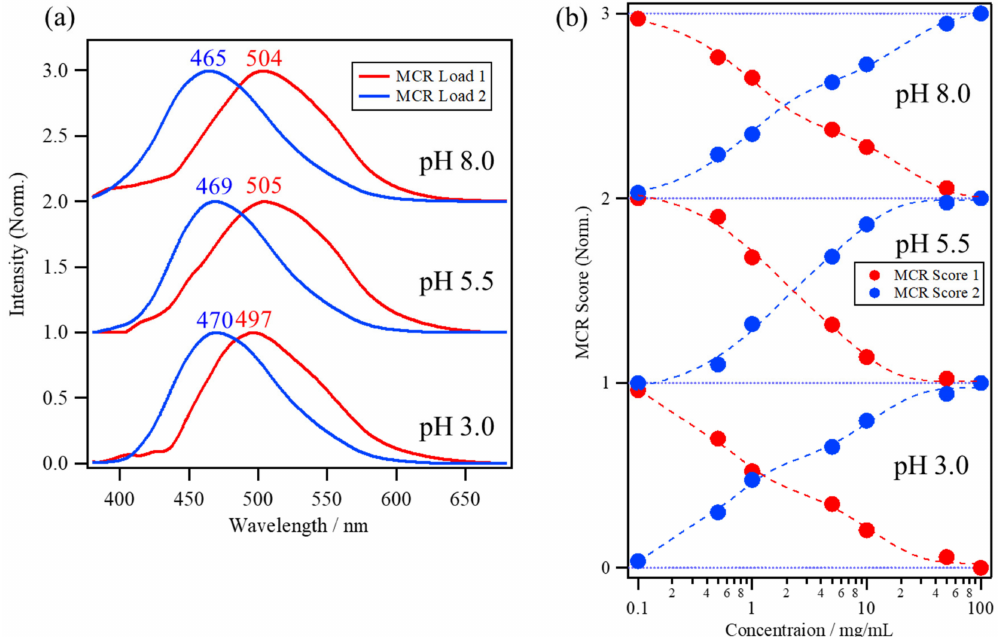
Figure 5. ( a ) The multivariate curve resolution (MCR) loadings and ( b ) scores of the ANS fluorescence spectra of lysozyme solutions at pH 8.0, 5.5, and